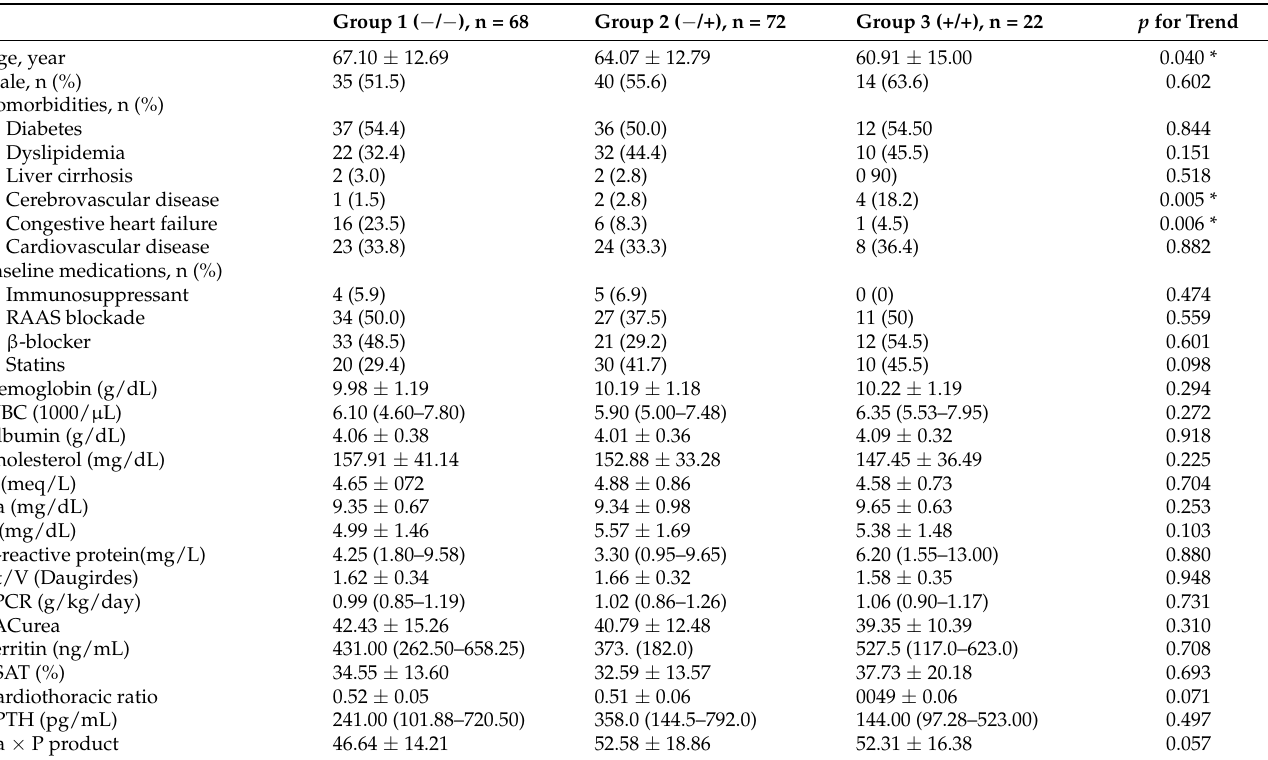
Table 2. Comparison of factors associated with dynamic changes of humoral responses after two doses of ChAdOx1.